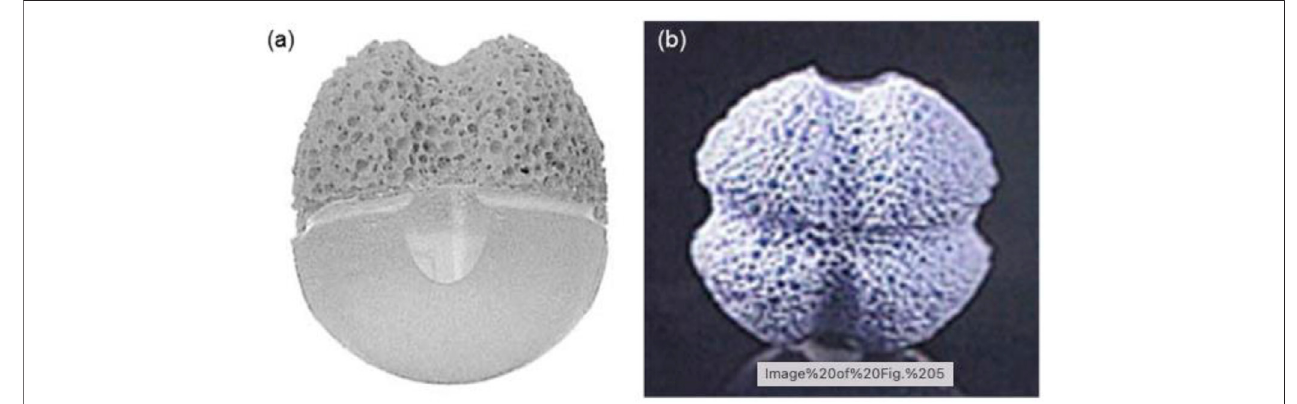
FIGURE 7 | Illustration of the Guthoff implant: (A) lateral and (B) frontal views.